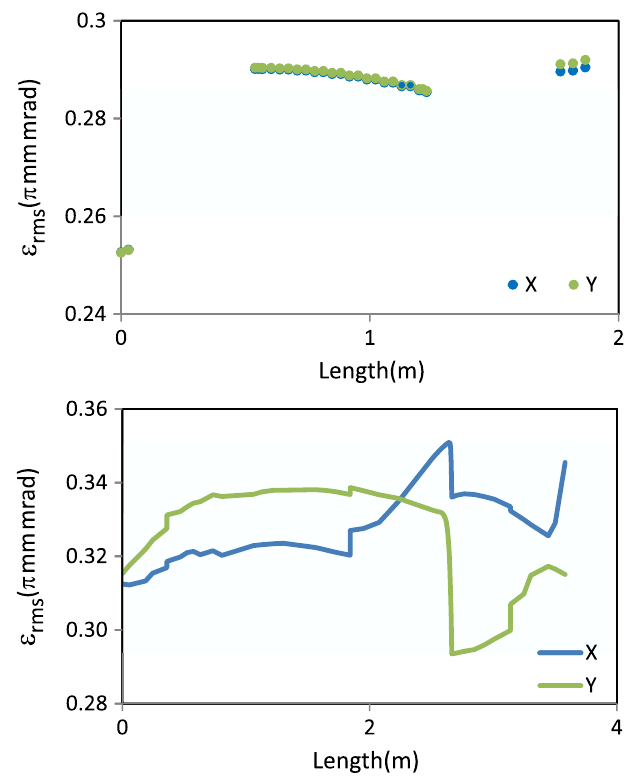
FIG. 3. (Color) Transverse emittance evolution. Top: LEBT with 8 mA, including 90% space-charge neutralization in the LEBT, the emittance inside the solenoid is not indicated (out of scale). Bottom: Chopper line with 65 mA. Positions of the rf cavities are marked with a vertical